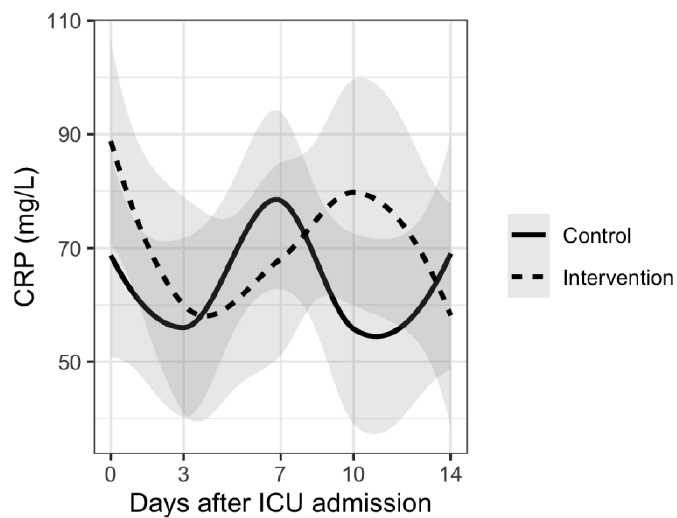
Figure 1. Mean CRP levels and trends during 14 days from ICU admission.